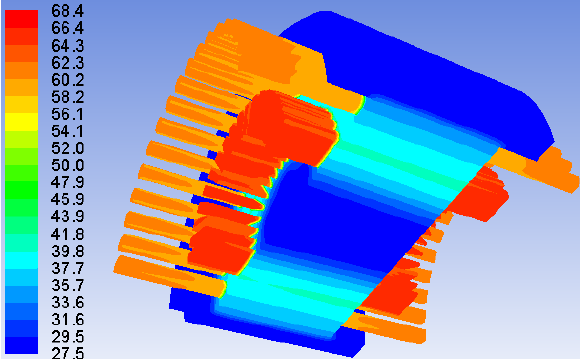
Figure 21. Thermal field distribution under condition of water cooling used in the casing and the inner rotor when both the SM and the DRM run at the low speed and rated load.